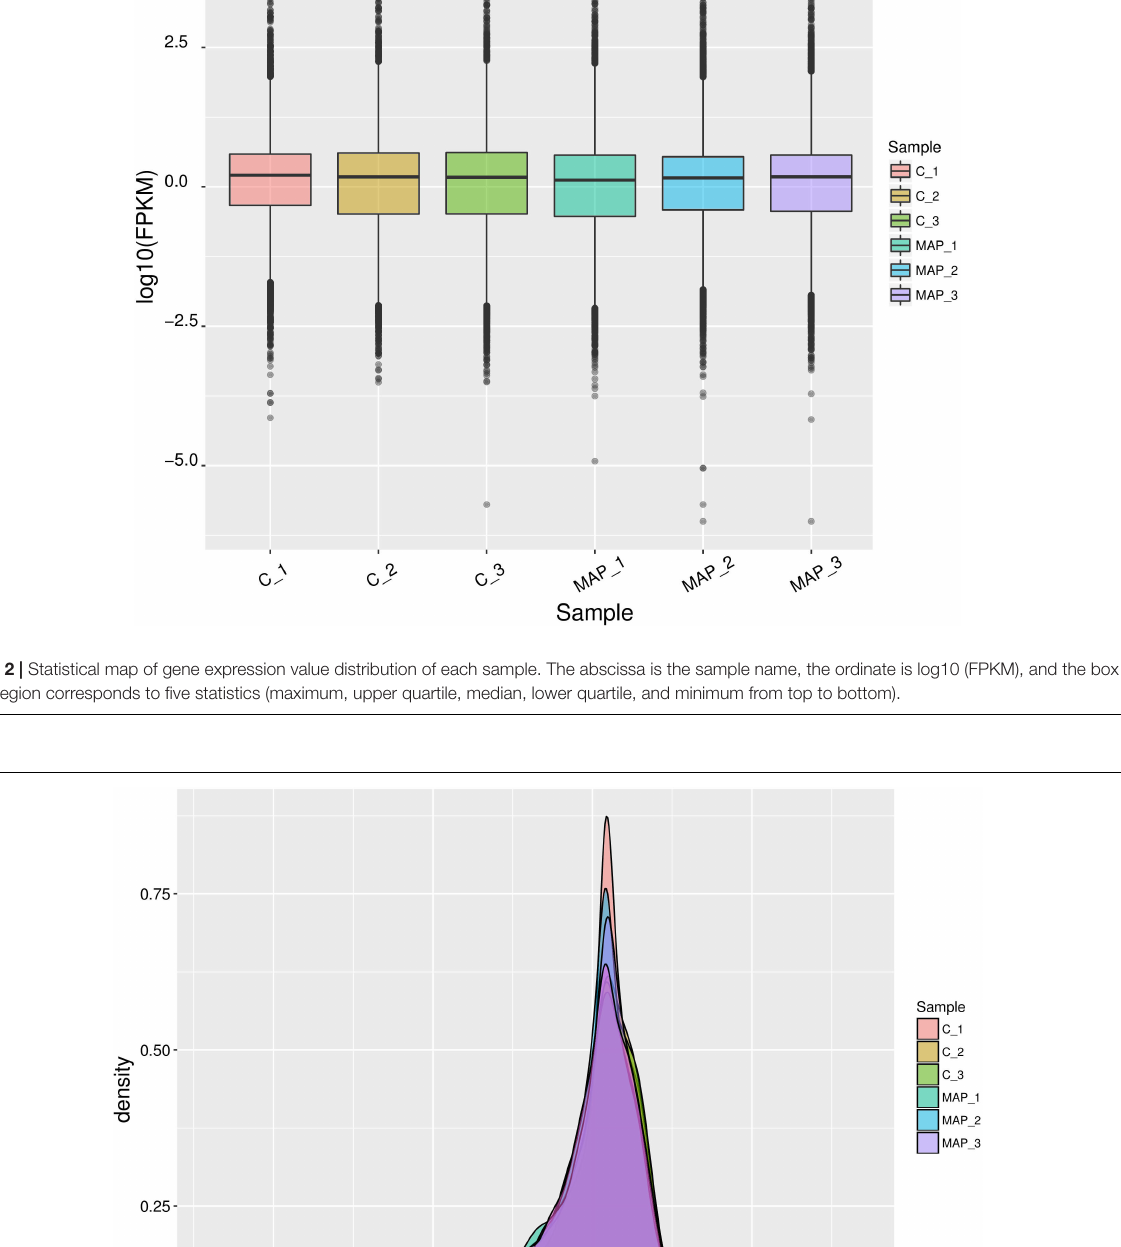
Frontiers in Microbiology |